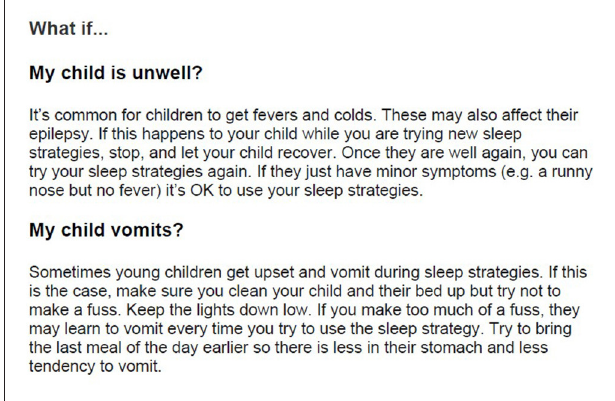
FIGURE 7 | Example of COSI content from module